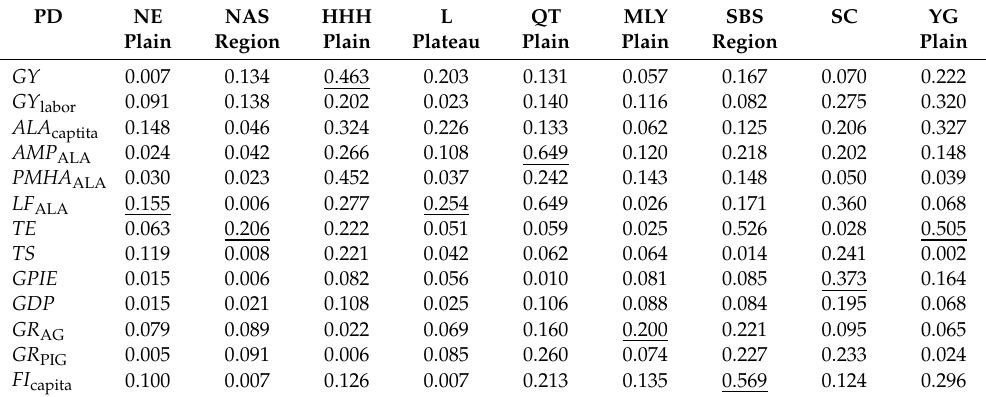
Table 6. The PD values as derived from the Geo-Detector based on a standard deviation classification method for the influence of 13 factors on cropping intensity changes. The maximum PD values for each region are